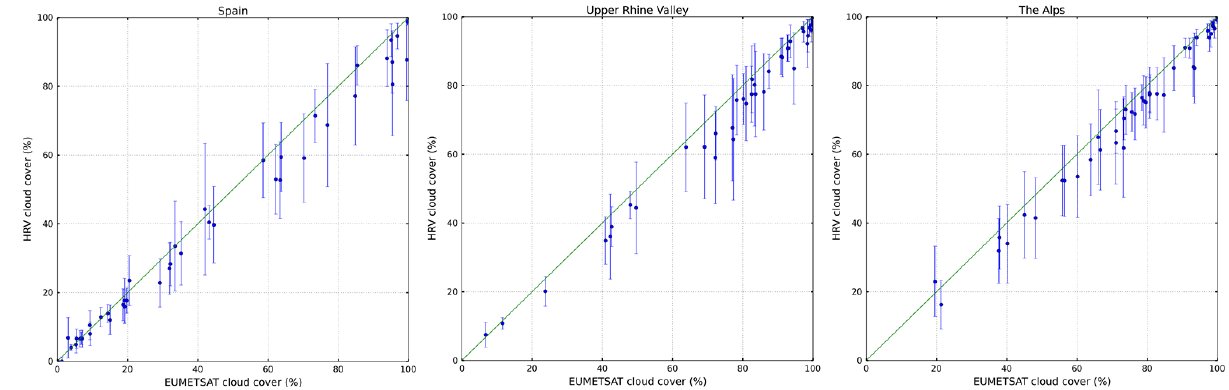
Fig. 10. Comparison of the cloud coverage of the EUMETSAT and HRV cloud masks after thin cloud restoral. The blue dots show the cloud